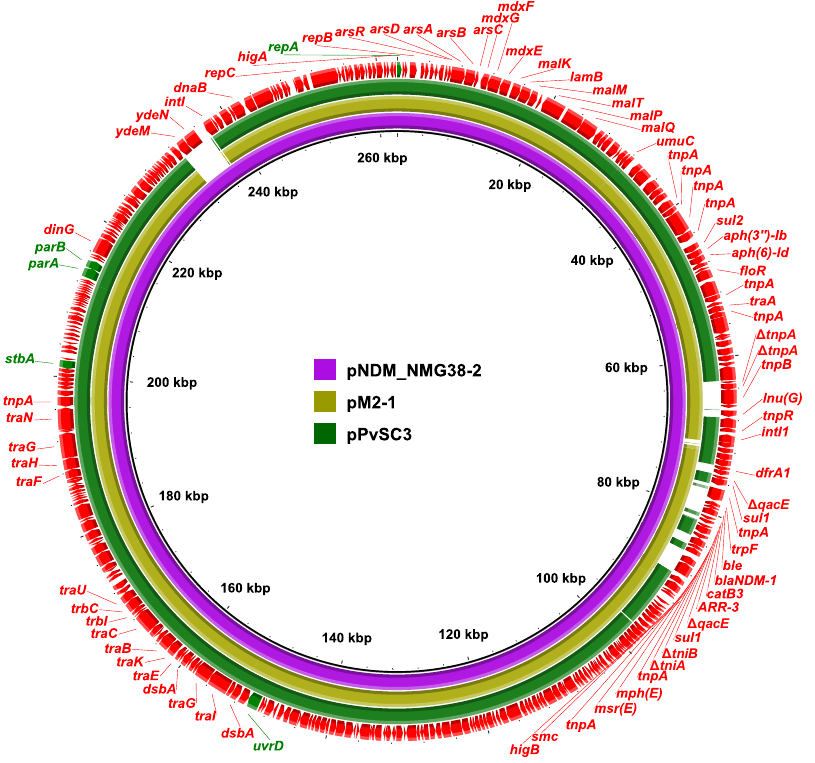
Figure 2. Circular comparisons of pNDM_NMG38-2 with pPvSC3 and pM2-1. pNDM_NMG38-2 was used as a reference to compare with other plasmids. The outer circle with red arrows denotes the annotation of reference plasmid, with arrows indicating deduced ORFs and their orientations. Gaps indicate regions that were missing in the respective plasmid compared to the reference plasmid. Key backbone genes are indicated in green.